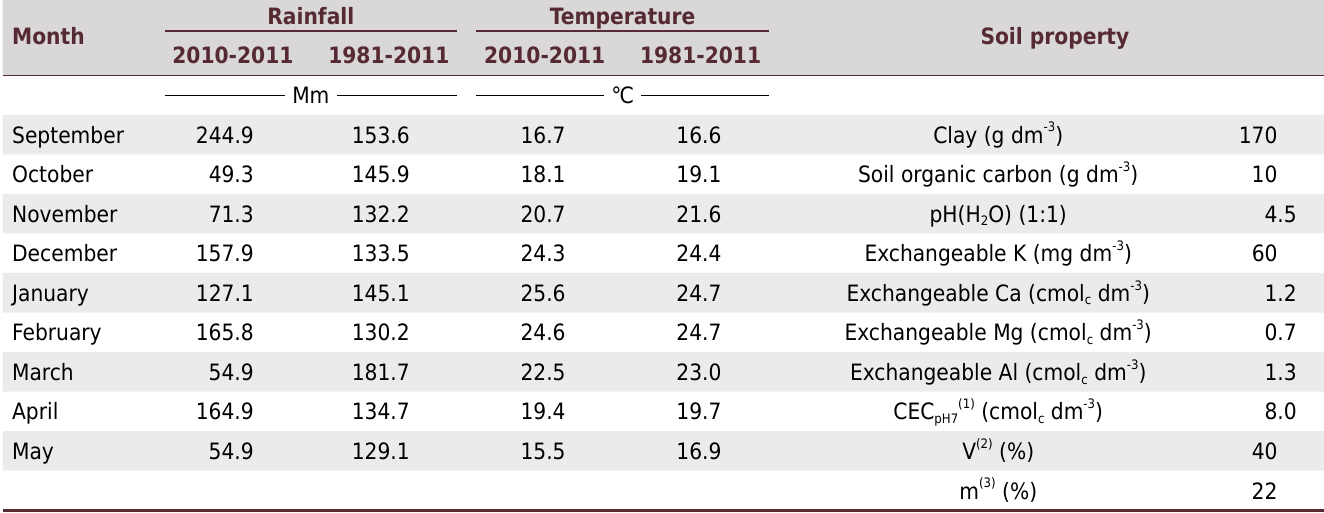
Table 1. Monthly rainfall and temperature over the study period (2010-2011) and over a 30-years period (1981-2011), and soil physical and chemical properties in the 0.10 m soil depth in natural grassland from Southern Brazil before the establishment of the experimental